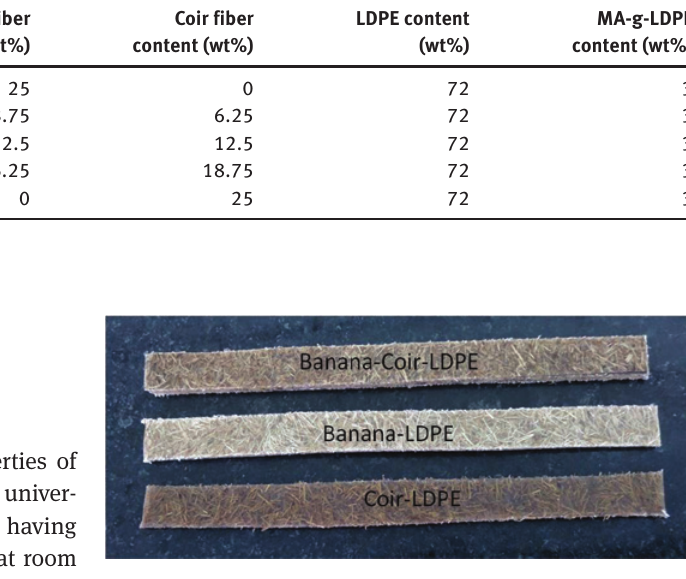
Figure 2: Flexural test specimens.